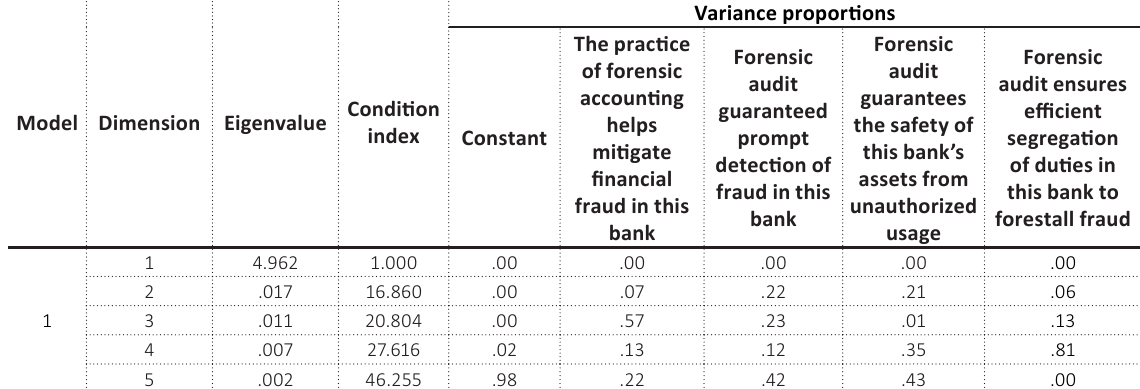
Model Dimension Eigenvalue Condition